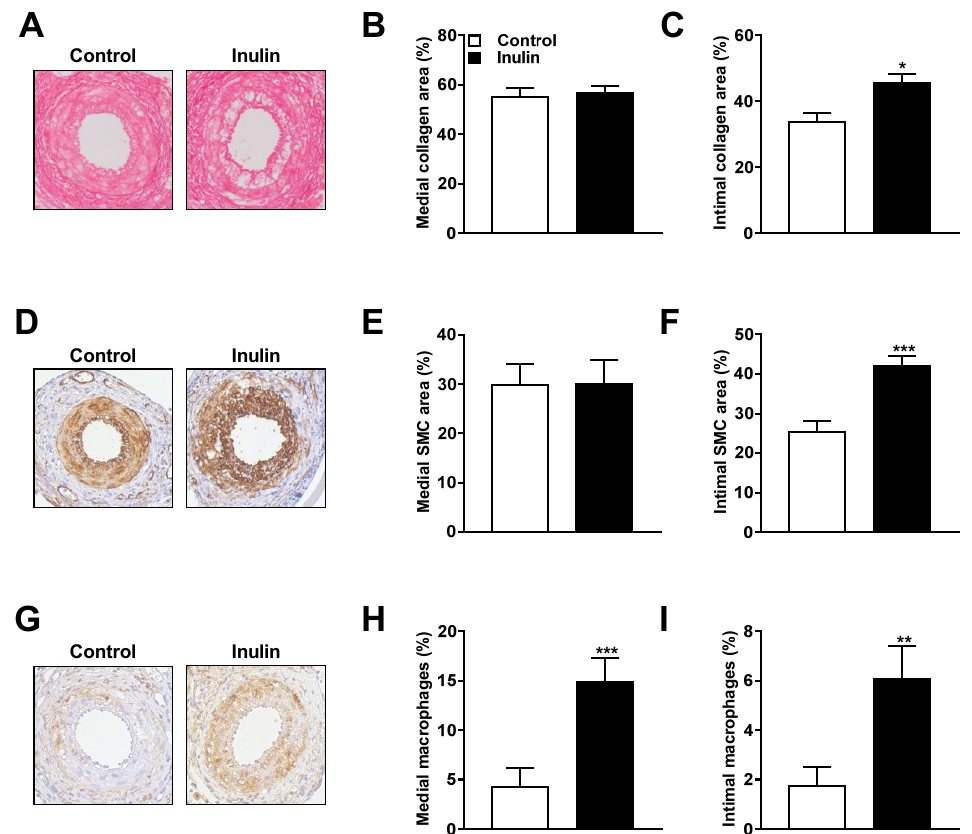
Figure 3. Inulin-induced changes in lesion composition. Representative cross-sections and quantitative analysis for medial and intimal lesion areas of the cuffed femoral arteries of E3L mice stained with ( A – C ) Sirius red for collagen; ( D – F ) α -actin for SMCs; and ( G – I ) MAC3 for macrophages. Values are presented as means ± SEM ( n = 11–13 mice per group). * p < 0.05, ** p < 0.01, *** p < 0.001 vs. control.